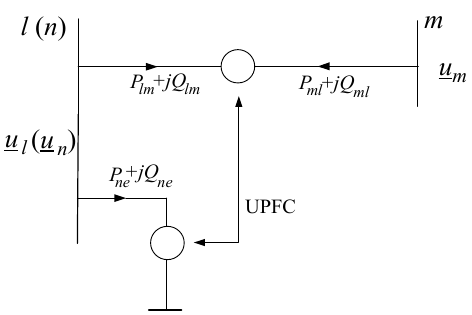
Figure 3. The equivalent model of the conventional structure UPFC.